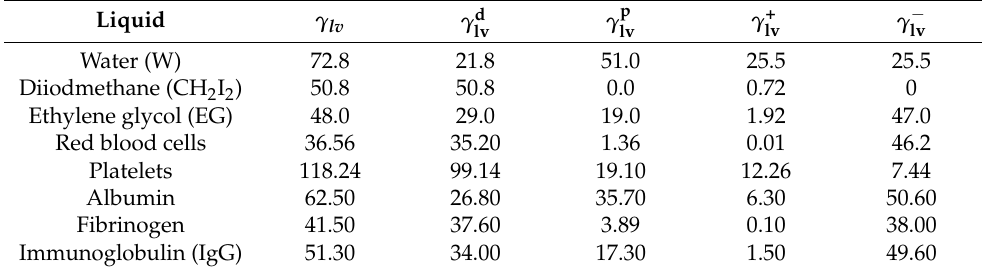
Table 4. Surface tension parameters of the liquids used [47–53].